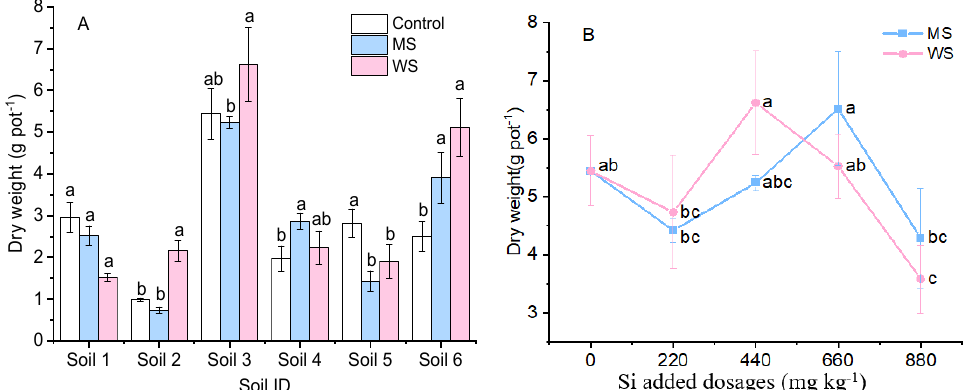
Figure 1. Dry weight of amaranth shoot in six Cd-contaminated soils under 440 mg · kg − 1 Si treatments ( A ) and in soil 3 under 0, 220, 440, 660, and 880 mg · kg − 1 Si added dosages ( B ). Control, non-amendment treatment; MS, 4A molecular sieve; WS, wollastonite. Data are means ± SE ( n = 4). Different letters above the adjacent bars or lines denote a significant ( p < 0.05) difference among the treatments in the same soil.